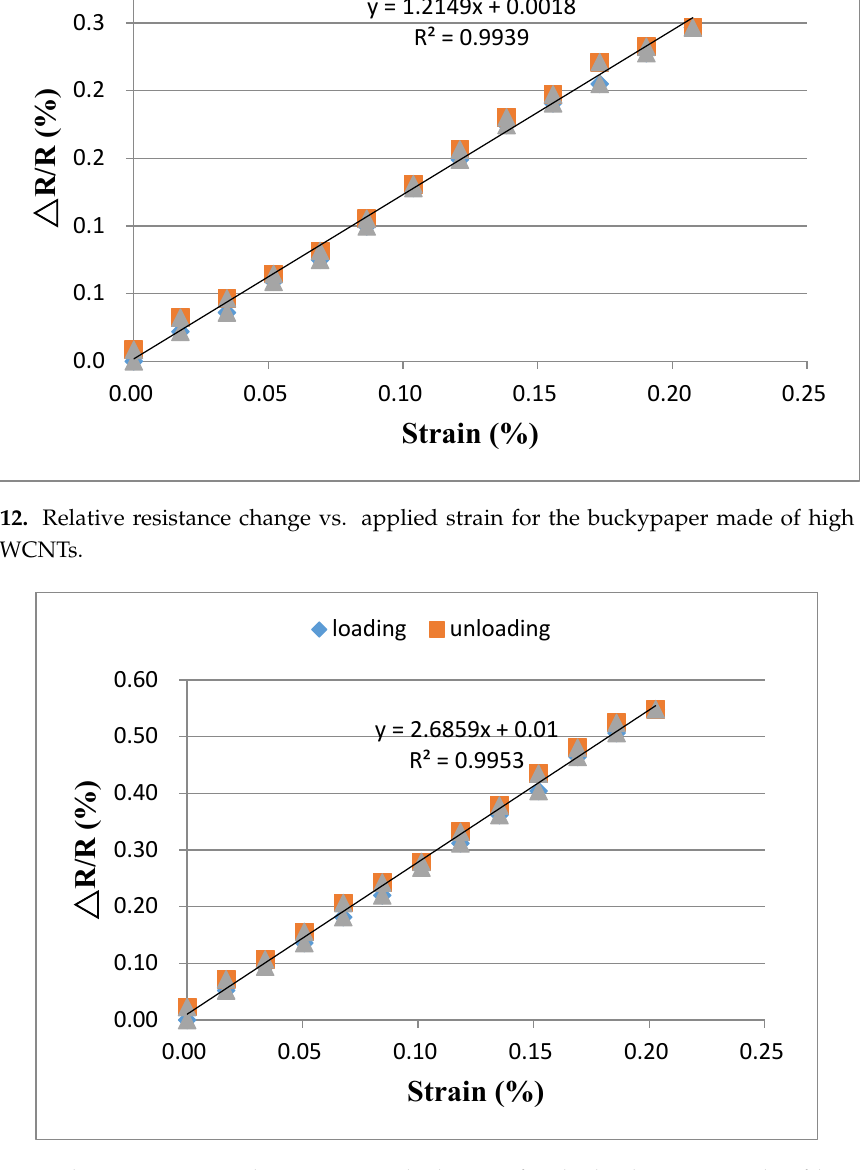
Figure 13. Relative resistance change vs. applied strain for the buckypaper made of low aspect ratio MWCNTs.